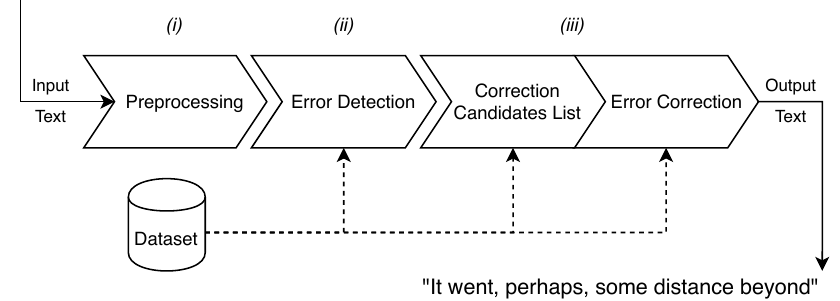
Figure 2. Workflow of the spelling correction